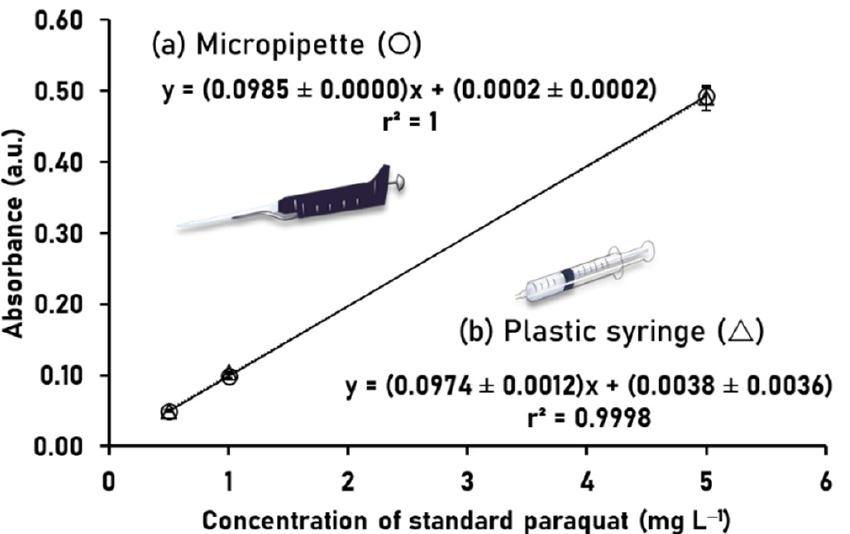
Figure 7. Calibration curves of paraquat with investigating the possibility study for use of ( a ) micropipette and ( b ) plastic syringe for liquid handling (10 mL for standard/sample solution and 1 mL for color-forming reagent.